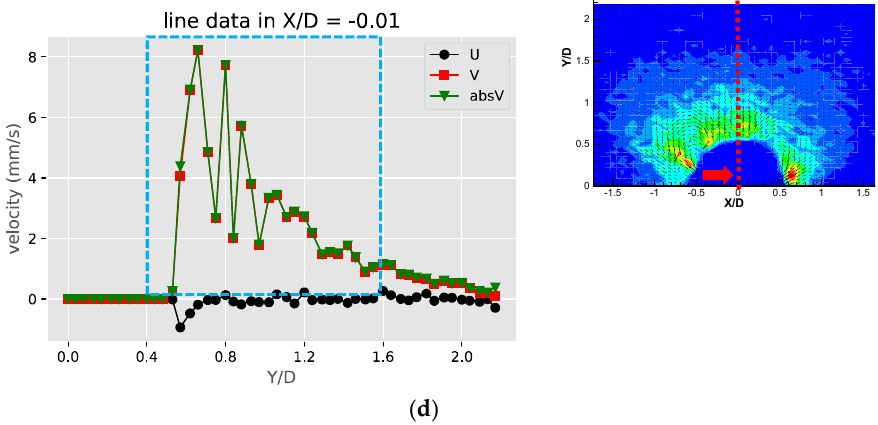
Figure 7. The profiles of velocity components in the X and Y directions (U, V) and absolute velocity (absV) of the liquid droplet obstructions: ( a ) Y/D = 0.57; ( b ) X/D = −0.56; ( c ) X/D = 0.53 and ( d ) X/D = −0.01.